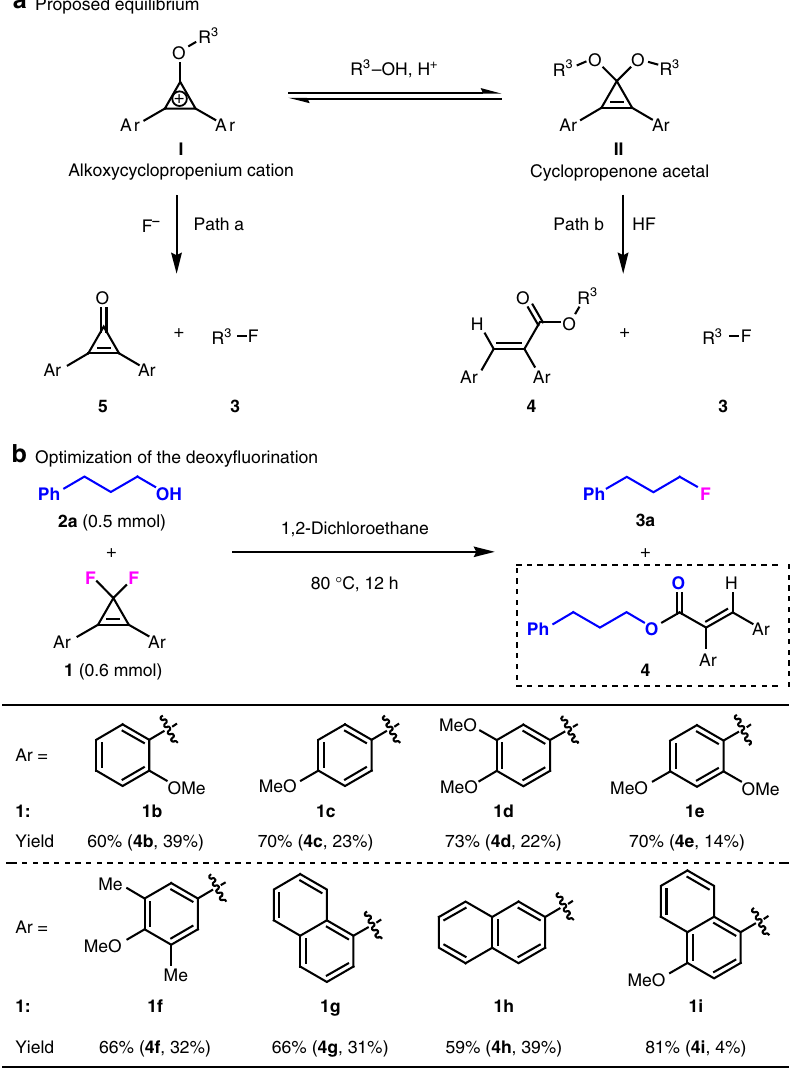
Figure 2 | Substitution effect on the outcome of the deoxyfluorination. ( a ) A proposed competitive reaction pathway that arises from an equilibrium between alkoxycyclopropenium cation I and cyclopropenone acetal II . ( b ) Optimization on the deoxyfluorination via screening CpFluors with different aryl substitutents. Yields of 3a were determined by 19 F NMR spectroscopy using PhCF 3 as an internal standard. Yields of 4 refer to the isolated